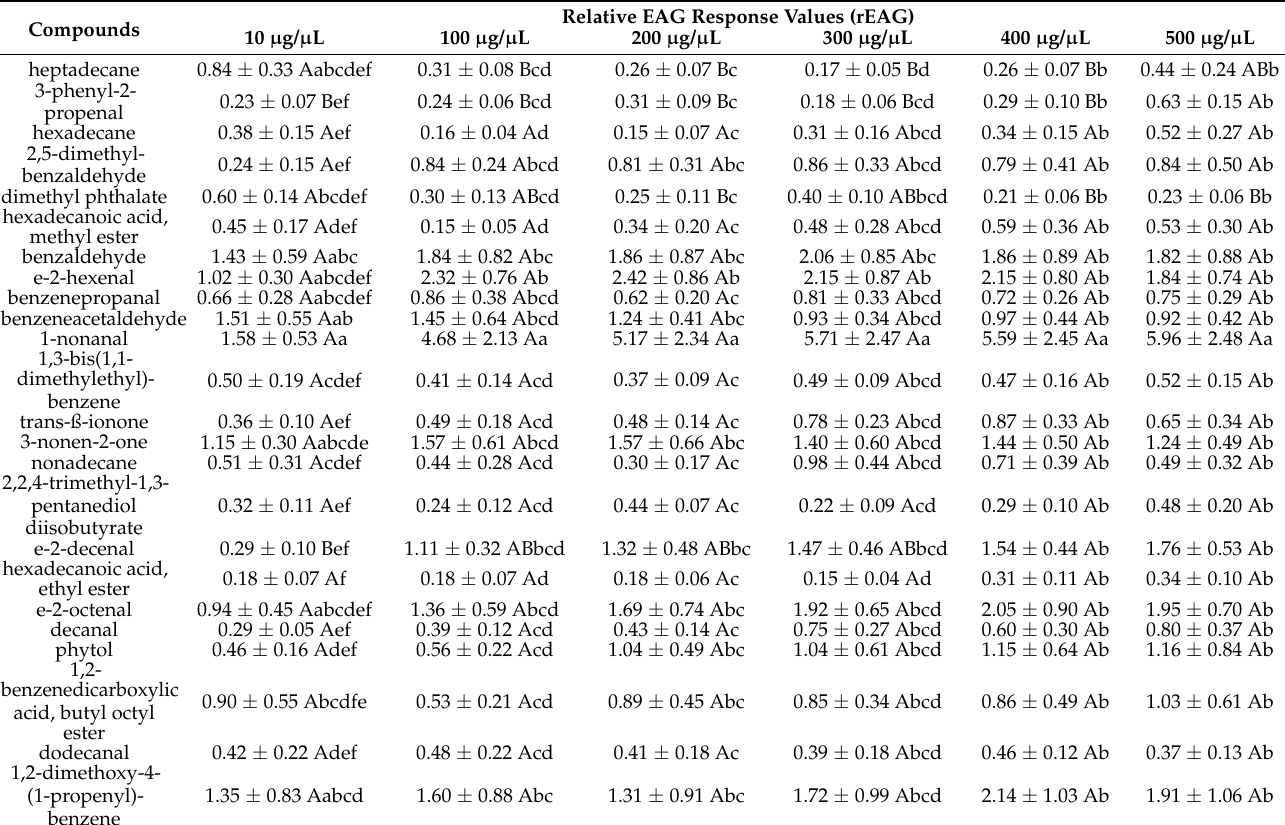
Table A1. The relative EAG response values of Apis mellifera